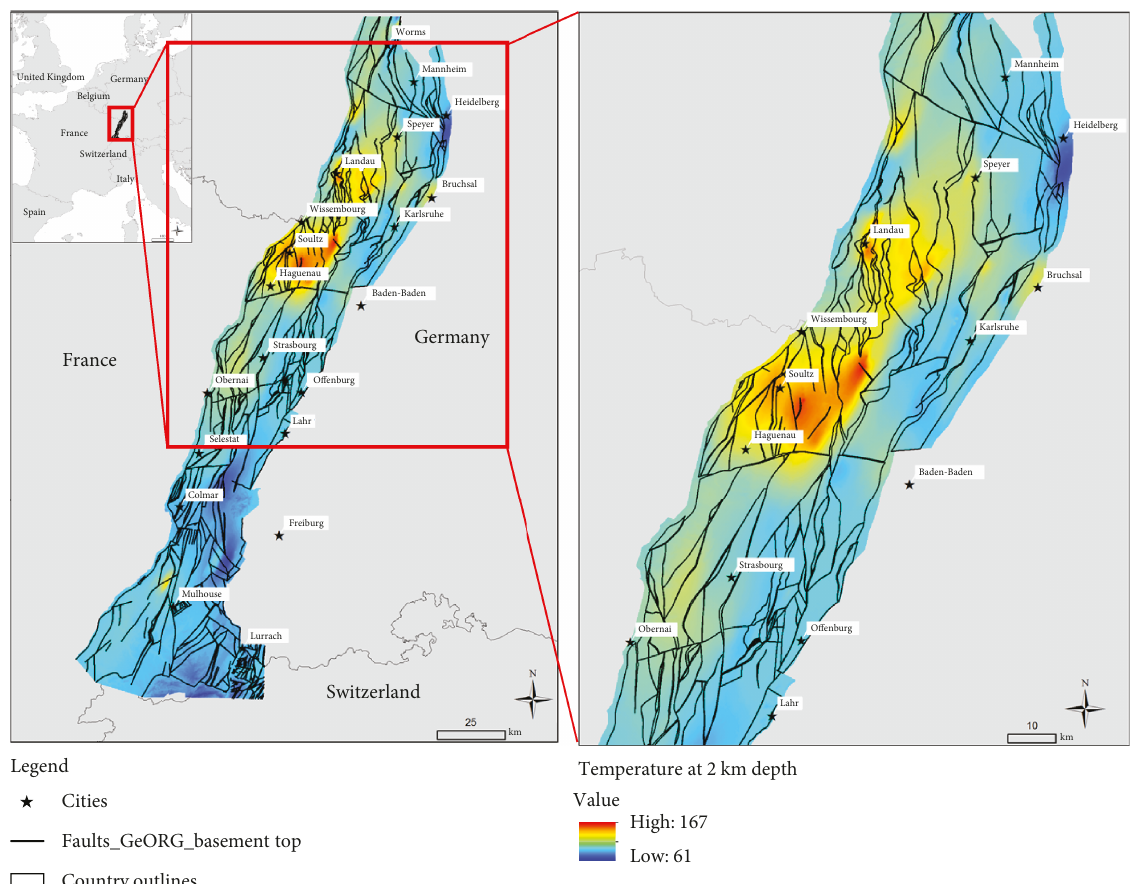
Figure 1: Location of the URG and of the case study in the URG. The map shows the faults at the top of the basement and the temperature map at 2km depth delivering the main thermal anomalies (GeORG